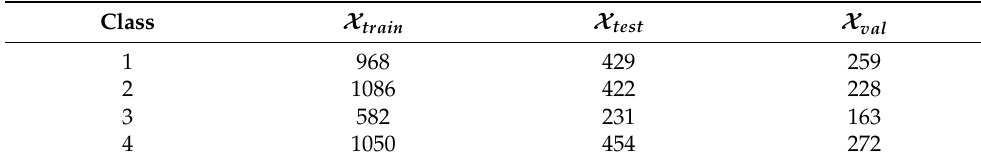
Table 1. Overview of the number of data within the dataset split in into training, test and validation sets. Based on the summation of all classes consists of 0.6, of 0.25 and of 0.15 based X train X test X val of the total amount of data. Class X train X test X val 1 968 429 259 2 1086 422 228 3 582 231 163 4 1050 454